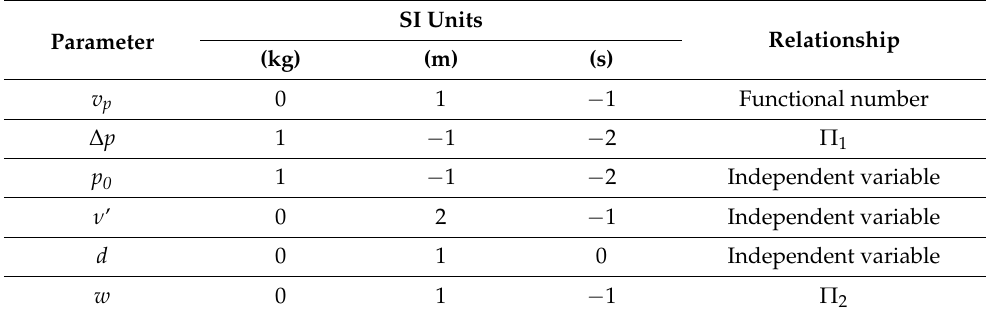
Table A1. Dimensional relationships between parameters explaining the velocity of pressure-change signal, v p.